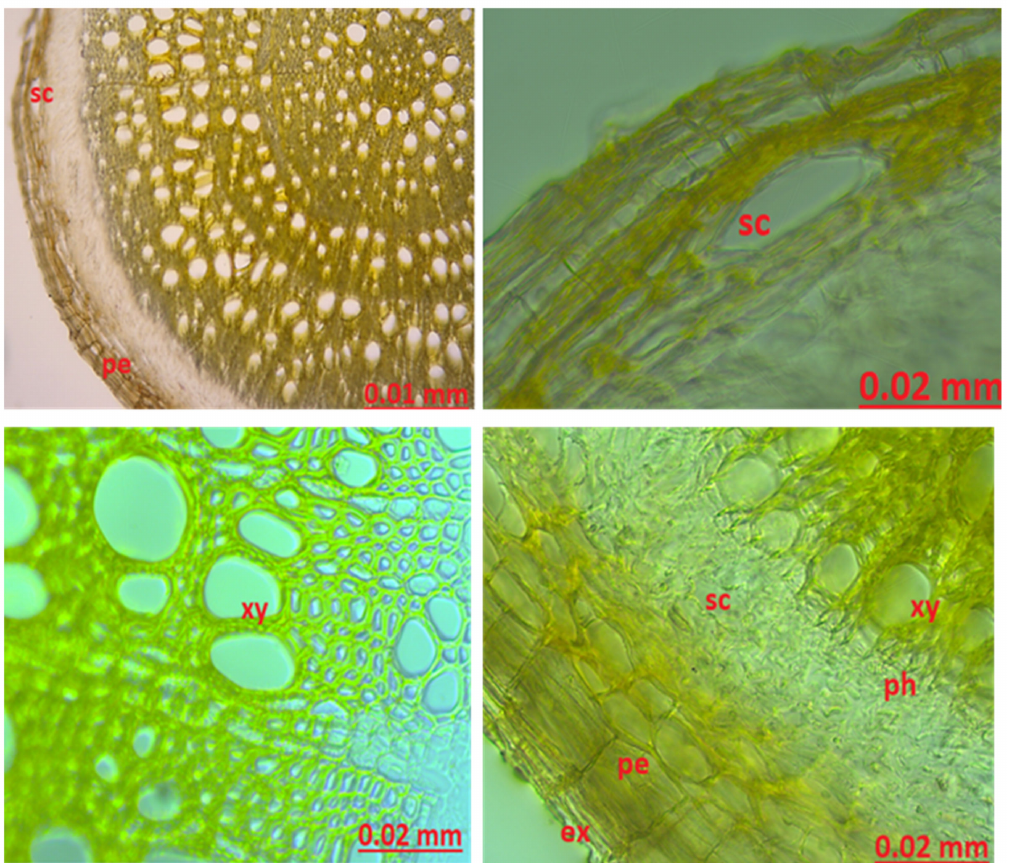
Figure 1. The root anatomy of Hypericum scabrum ; ex: exoderm, pe: periderm, sc: secretory canals, ph: phloem, xy: xylem.